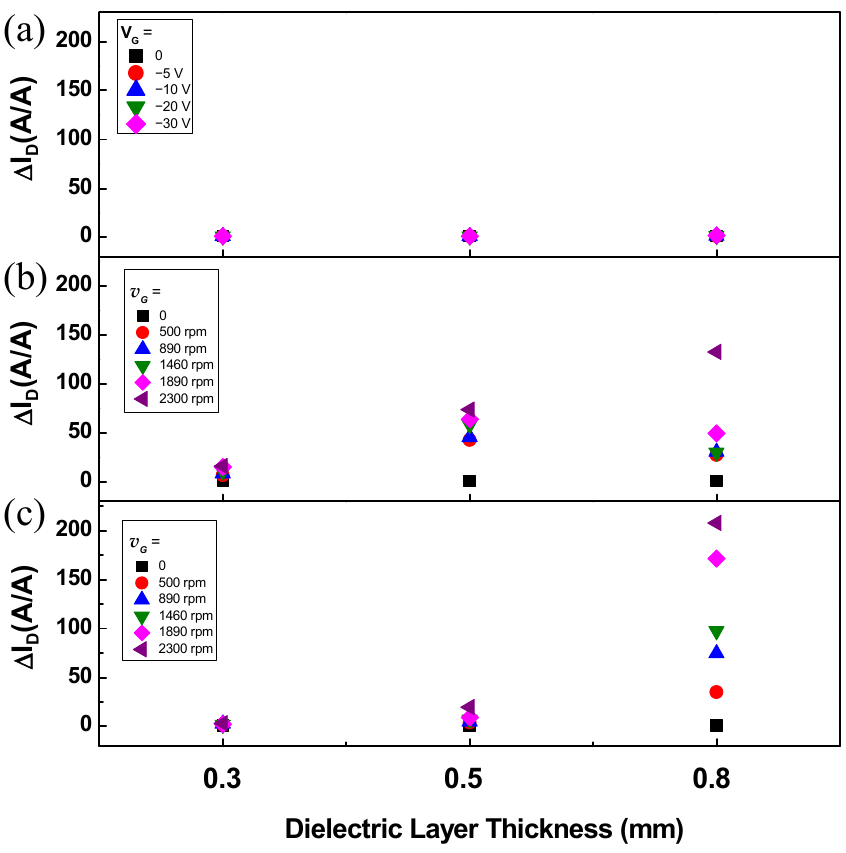
Figure 6. Comparison of the increase in the drain current ( I D ) according to ( a ) the gate voltage of a conventional transistor structure and ( b , c ) the gate rotation velocity ( v G ) of the fabricated RGT.